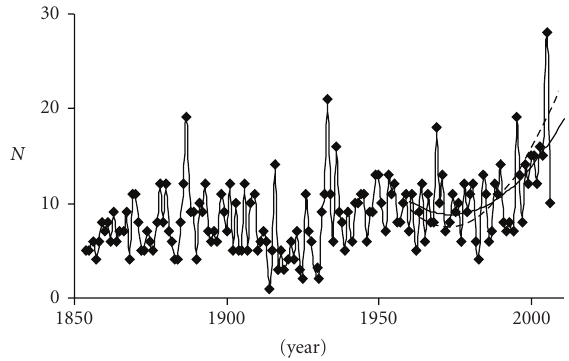
Figure 6: Number of storms predicted per year during the period 1854–2006 versus numbers actually observed for the Atlantic (filled diamonds). The model predictions (grey curve) have been normalized to the data. A quadratic fit to the model is shown for the period